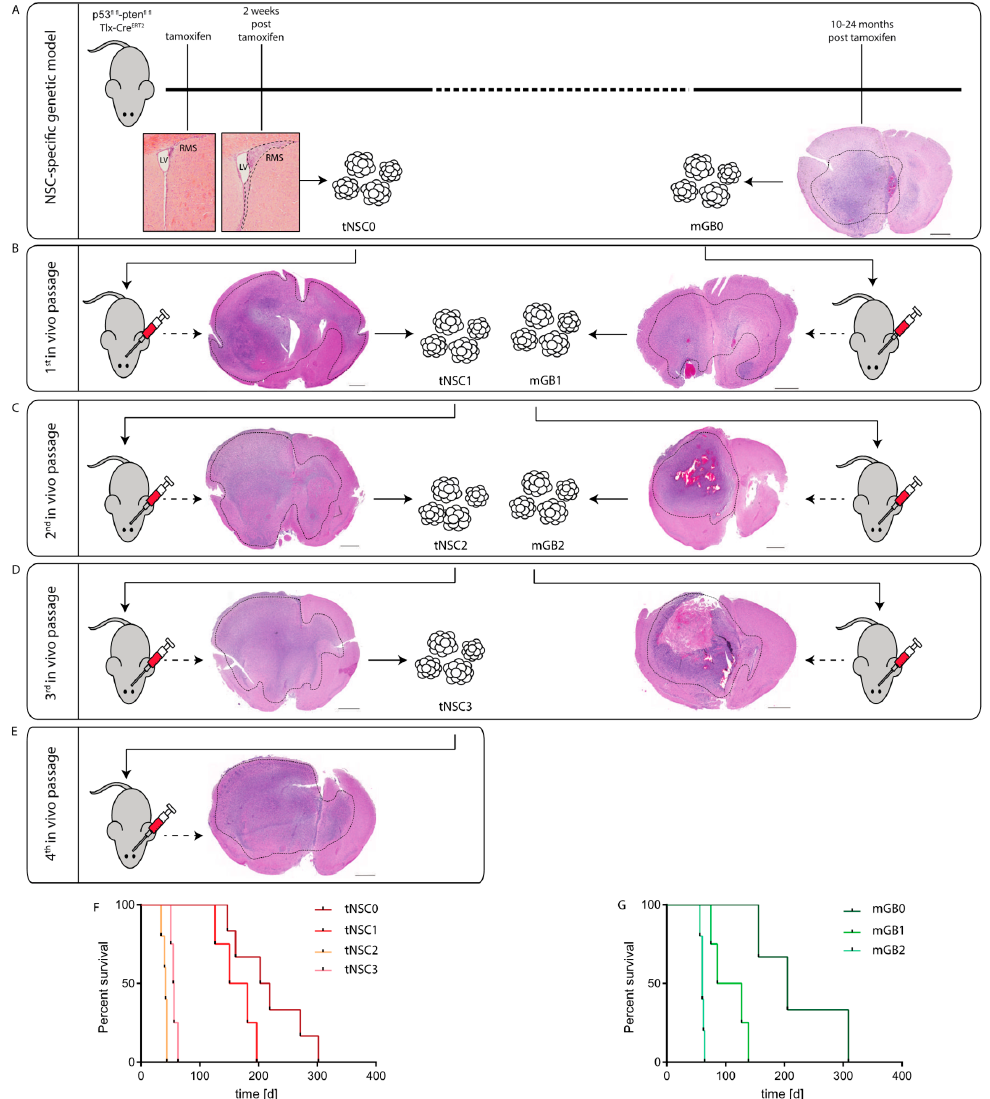
Figure 1. Generation of syngeneic glioma cell lines through in-vivo passaging of Pten / p53 -deleted cells isolated from a genetic glioma model. ( A ) Schematic representation of the Pten / p53 genetic glioma model from which NSCs have been isolated either at early pre-malignant stage (left panel) or from a full-blown tumor (right panel). Scale bar = 1000 µ m. Left panel: lateral ventricle (LV) with rostral migratory stream (RMS) at time of tamoxifen injection and at 2 weeks after tamoxifen-induced Pten/p53 recombination. Sections were stained with hematoxylin and eosin (H&E). Right panel: section of a full-blown tumor developed 18 months after tamoxifen-induced Pten/p53 deletion. Section was stained with hematoxylin and eosin (H&E). Scale bar = 1000 µ m Dotted line shows tumor area. ( B ) First in vivo passage of tNSC0 (left panel) and mGB0 (right panel). Representative picture of a tNSC0-derived (left panel) and mGB0-derived (right panel) glioma. Sections were stained with hematoxylin and eosin (H&E). Scale bars = 1000 µ m, ( C ) second in vivo passage of tNSC1 (left panel) and mGB1 (right panel). Representative picture of a tNSC1-derived (left panel) and mGB1-derived (right panel) glioma. Sections were stained with hematoxylin and eosin (H&E). Scale bars = 1000 µ m. ( D ) Third in vivo passage of tNSC2 (left panel) and mGB2 (right panel). Representative picture of a tNSC2-derived (left panel) and mGB2-derived (right panel) glioma. Sections were stained with hematoxylin and eosin (H&E). Scale bar = 1000 µ m, ( E ) fourth in vivo passage of tNSC3 (left panel). Representative picture of a tNSC3-derived (left panel). Sections were stained with hematoxylin and eosin (H&E). Scale bar = 1000 µ m. ( F ) Kaplan–Meier survival curve of mice transplanted with tNSC0, tNSC1, tNSC2, and tNSC3 glioma cell lines. Time = days. tNSC0 ( n = 7), tNSC1 ( n = 6), tNSC2 ( n = 6), tNSC3 ( n = 7). ( G ) Kaplan–Meier survival curve of mice transplanted with mGB0, mGB1, and mGB2 glioma cell lines. Time = days. mGB0 ( n = 6), mGB1 ( n = 6), mGB2 ( n =